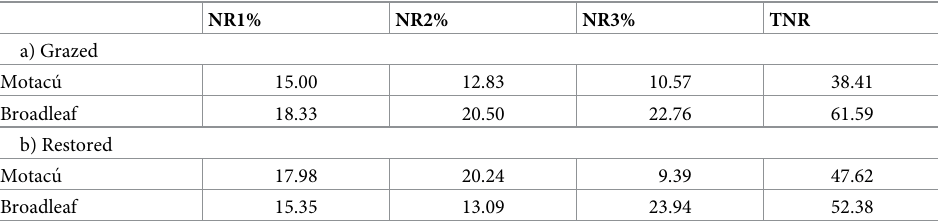
Table 2. Proportion of Natural Regeneration (NR) in our three height classes of motacu´ and broadleaf saplings (NR1: 1–2 m, NR2: 2–3 m; and NR3: > 3 m) and Total Natural Regeneration (TNR) on the a) grazed site and b) restored